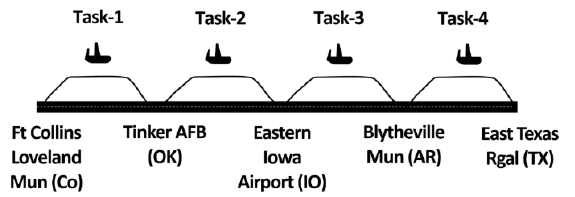
Figure 2. Four consecutive tasks (without any rest) labeled as tasks 1 through 4. Each task lasted approximately 1 h. The total duration was approximately 4 h.